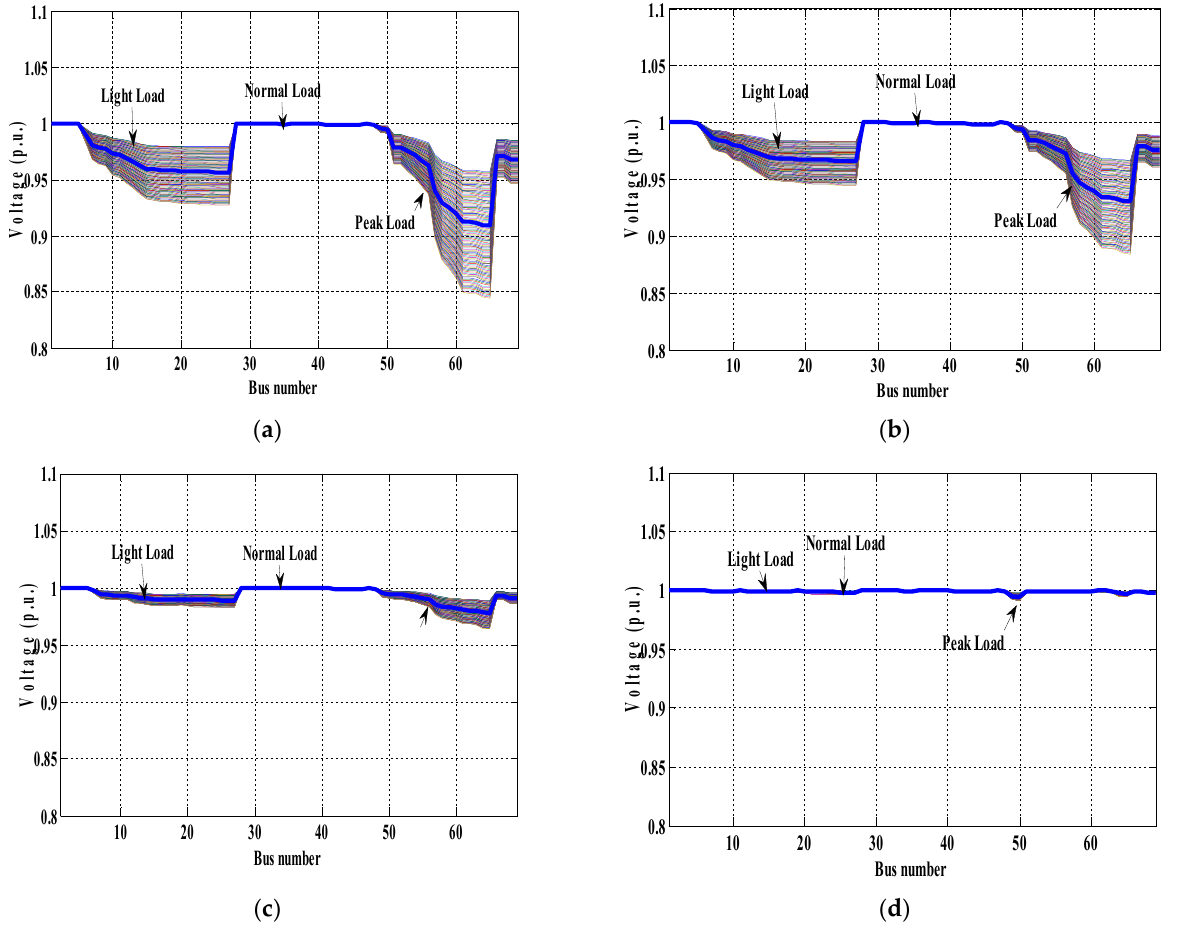
Figure 12. ( a ) IEEE 69-test system voltage profile (Scenario I). ( b ) IEEE 69-test system voltage profile (Scenario II). ( c ) IEEE 69-test system voltage profile (Scenario III). ( d ) IEEE 69-test system voltage profile (Scenario IV).